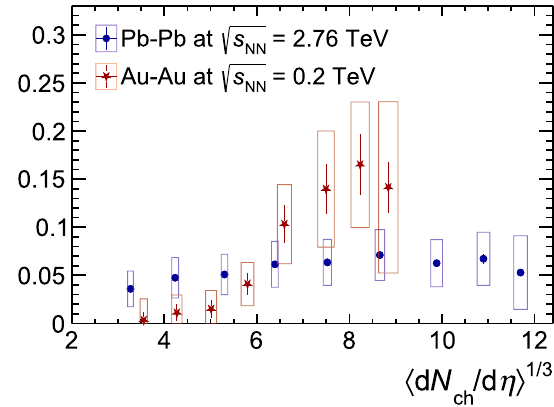
Fig. 3 Values of the shear viscosity per unit of entropy density, η/ s , correlator vs. the esti- √ 2 computed in this work, as a function of the cubic root of the charged s NN = √ particle density d N ch / d η measured in Pb–Pb collisions at s NN = 2 . 76 TeV [17], 2 . 76 TeV [17] and in Au–Au collisions at bars and error boxes represent statistical and systematic uncertainties, respectively